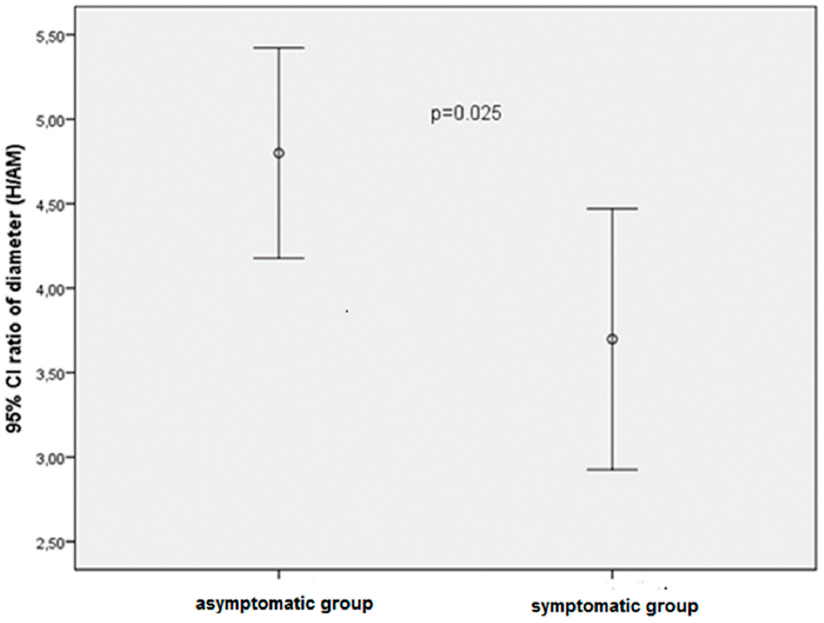
Figure 1. Comparison of 95% confidance intervals (CI) of diameter ratios (hilar/aortomesenteric portion) levels in asymptomatic and symptomatic patients.